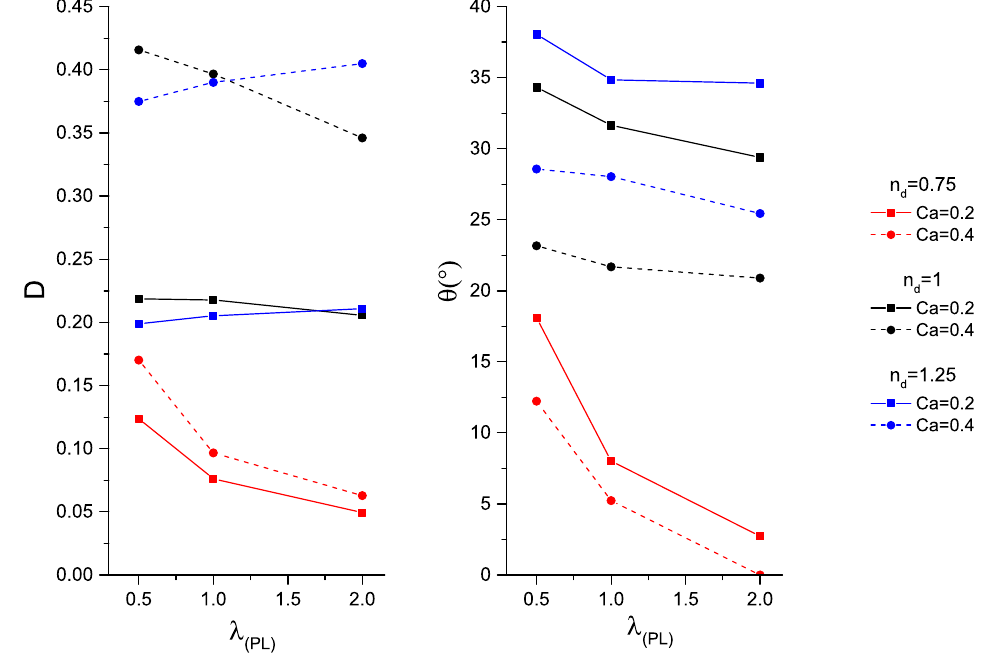
Figure 5. ( Left ) droplet deformation; and ( right ) orientation angle as a function of the power–law viscosity ratio, λ PL = k d / η c , for power–law exponents n d = 0.75, 1, 1.25, with confinement ratio, 2 R / H =